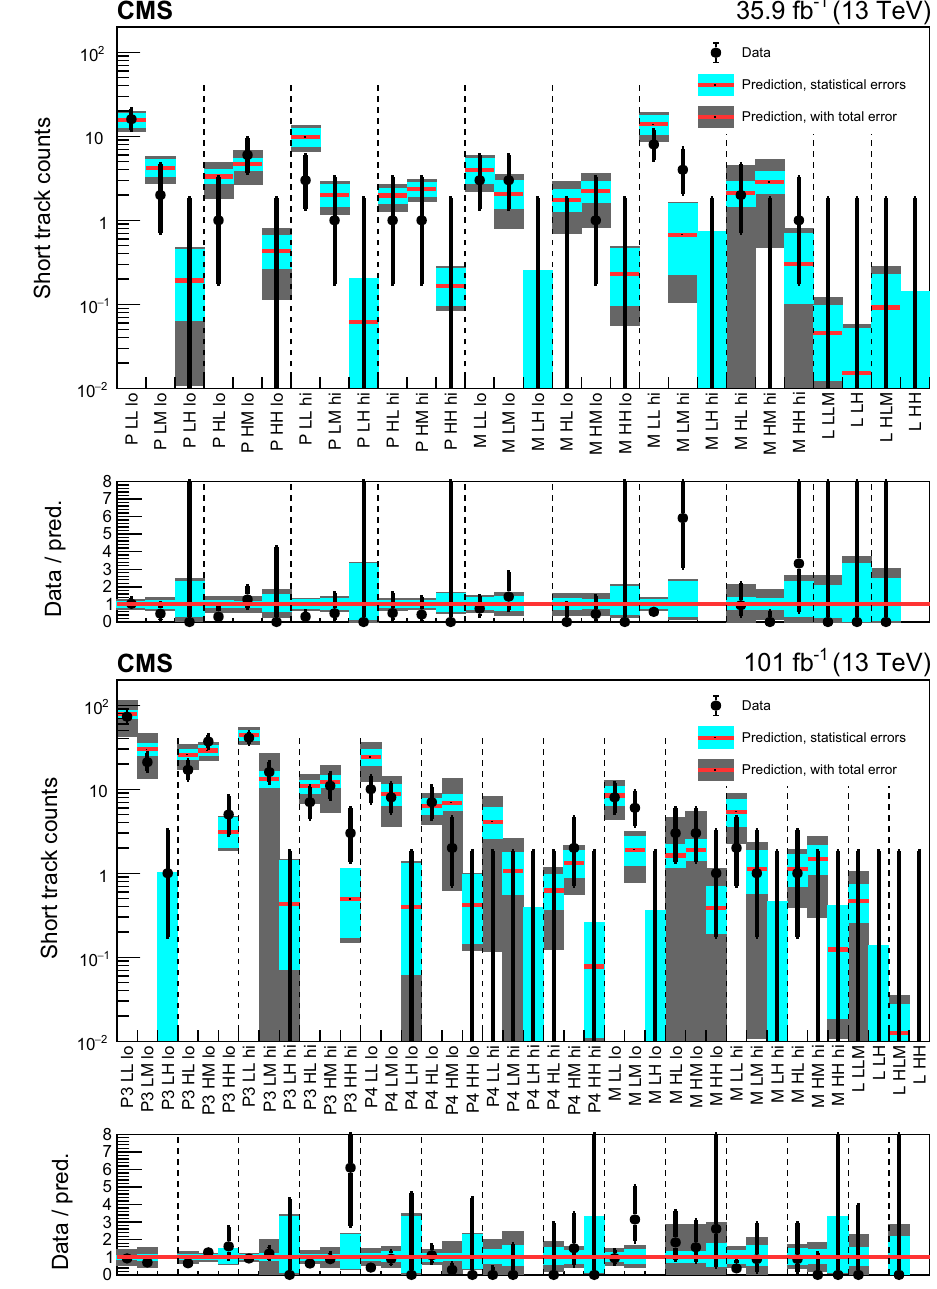
Data Prediction, statistical errors Prediction, with total